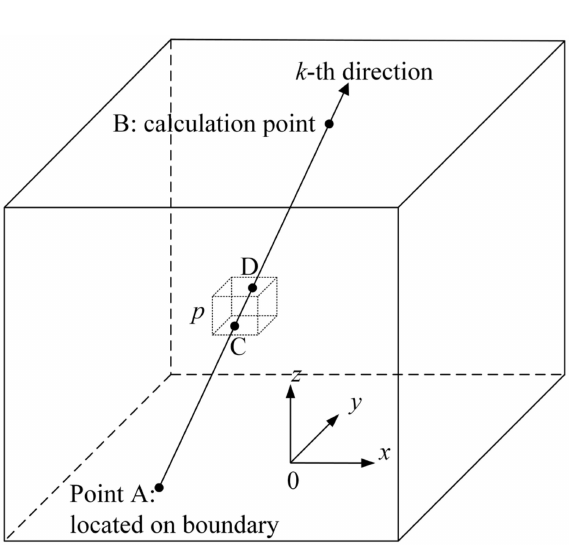
Figure 2. Calculation model for radiative intensity in a new direction in